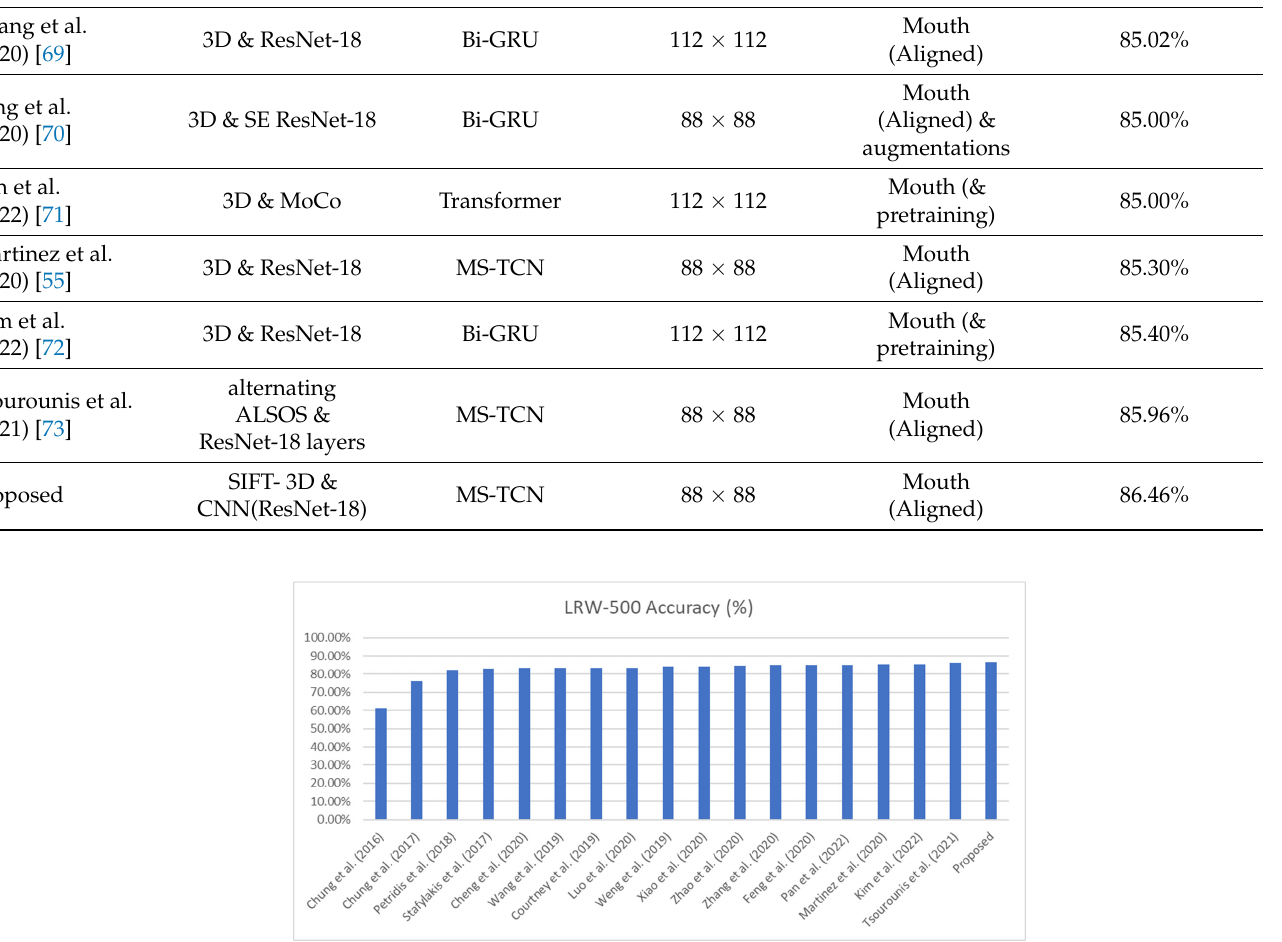
Figure 8. Bar plot presenting the state-of-the-art methods applied to the LRW-500 dataset.